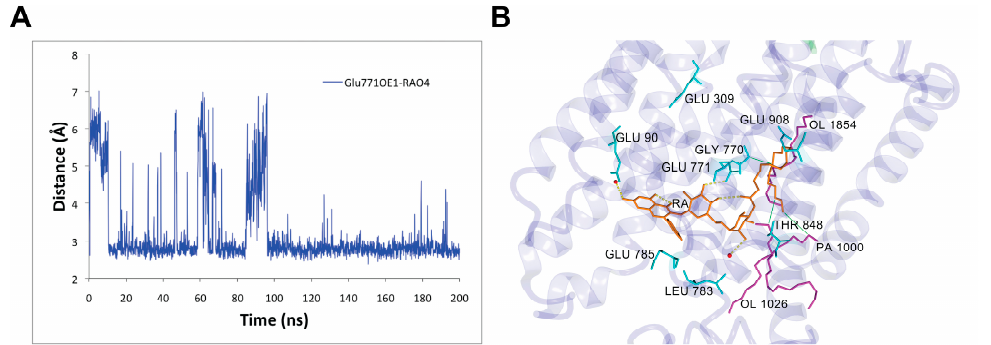
Figure 6. Rutin arachidonate (RA) binding site analysis. ( A ) Distance between the side chain of the carboxyl oxygen OE1 of Glu771 in SERCA1a and the hydroxyl hydrogen HO4 of RA as a function of time; ( B ) Binding mode of RA in SERCA1a. RA (in orange), residues (in cyan), and lipids (in magenta) are shown as a stick model. OL – oloeyl and PA – palmitoyl parts of 1-palmitoyl-2-oleoyl-sn glycero-3-PC (POPC). Hydrogen bonds are displayed as yellow dashed lines. Figure was rendered using YASARA [42]. Table 1. Hydrogen bonds analysis for the sarco/endoplasmic reticulum Ca 2+ -ATPase 1a– rutin arachidonate (SERCA1a-RA) complex (last 100ns).